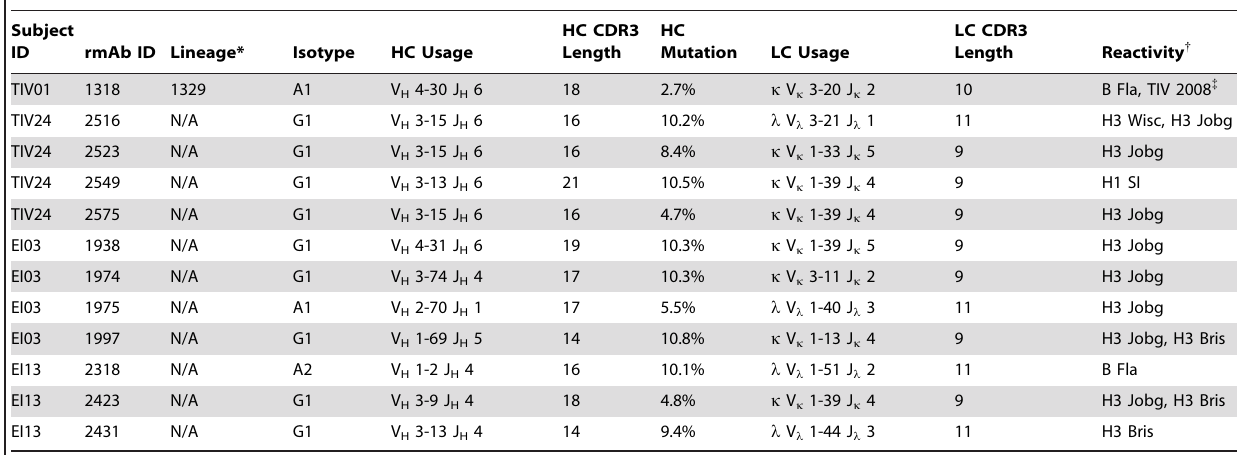
Table 2. Characteristics of OAS